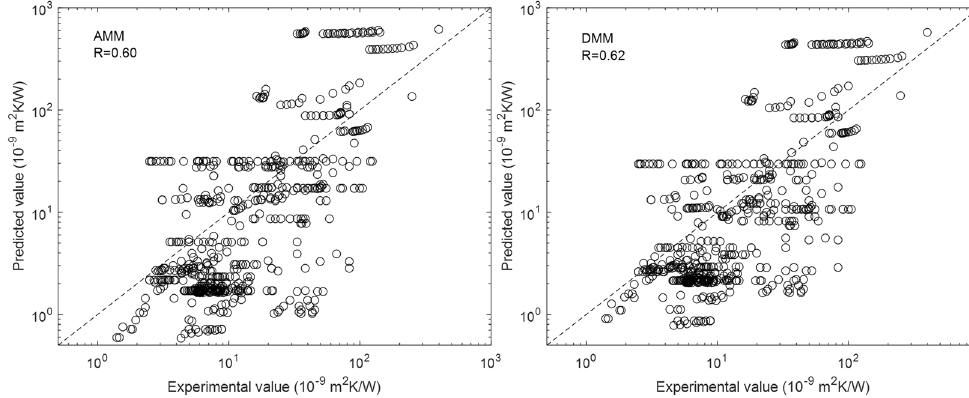
Figure 1. Correlation between the experimental values and the values predicted by the AMM and